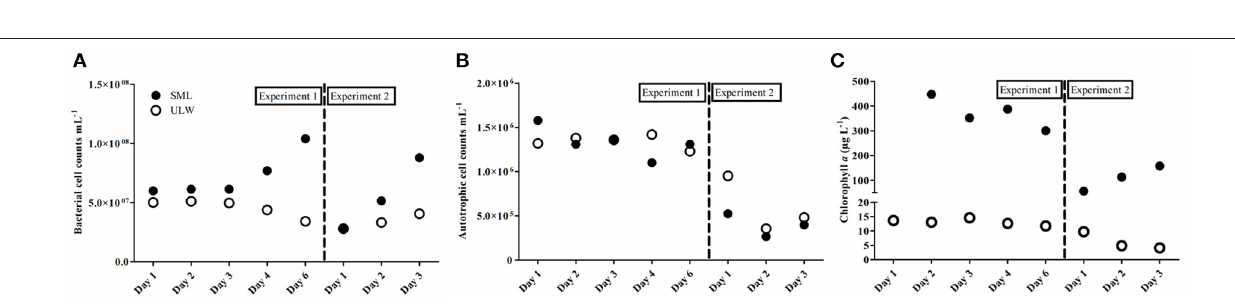
FIGURE 5 | Absolute cell abundance of bacteria (A) , small autotrophs (B), and chlorophyll a concentration (C) in the sea-surface microlayer (SML) and underlying water (ULW) for the two